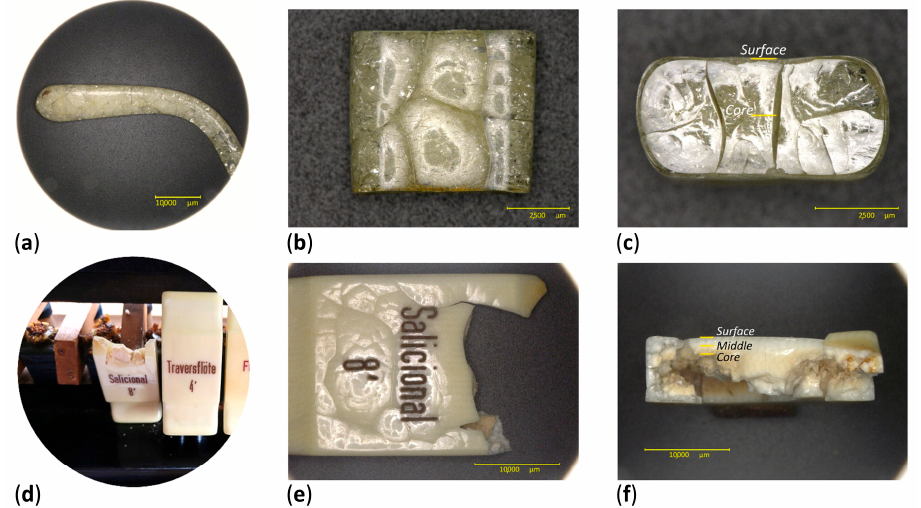
Figure 6. Original temple ( a ); side ( b ) and section ( c ) views of the analyzed fragment. Original con-